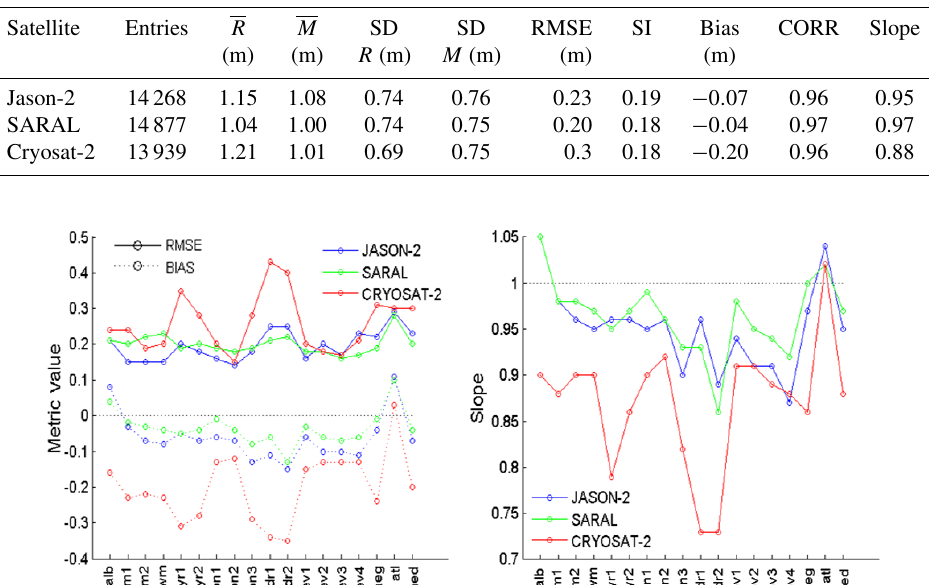
tions. At SARON (not shown), the surrounding topography is highly complex, including both orographic and bathymet- ric effects, resulting in highly scattered data around the refer- ence line. The right plot shows results at buoy location 61197 east of the Balearic Islands. This is a well-exposed offshore